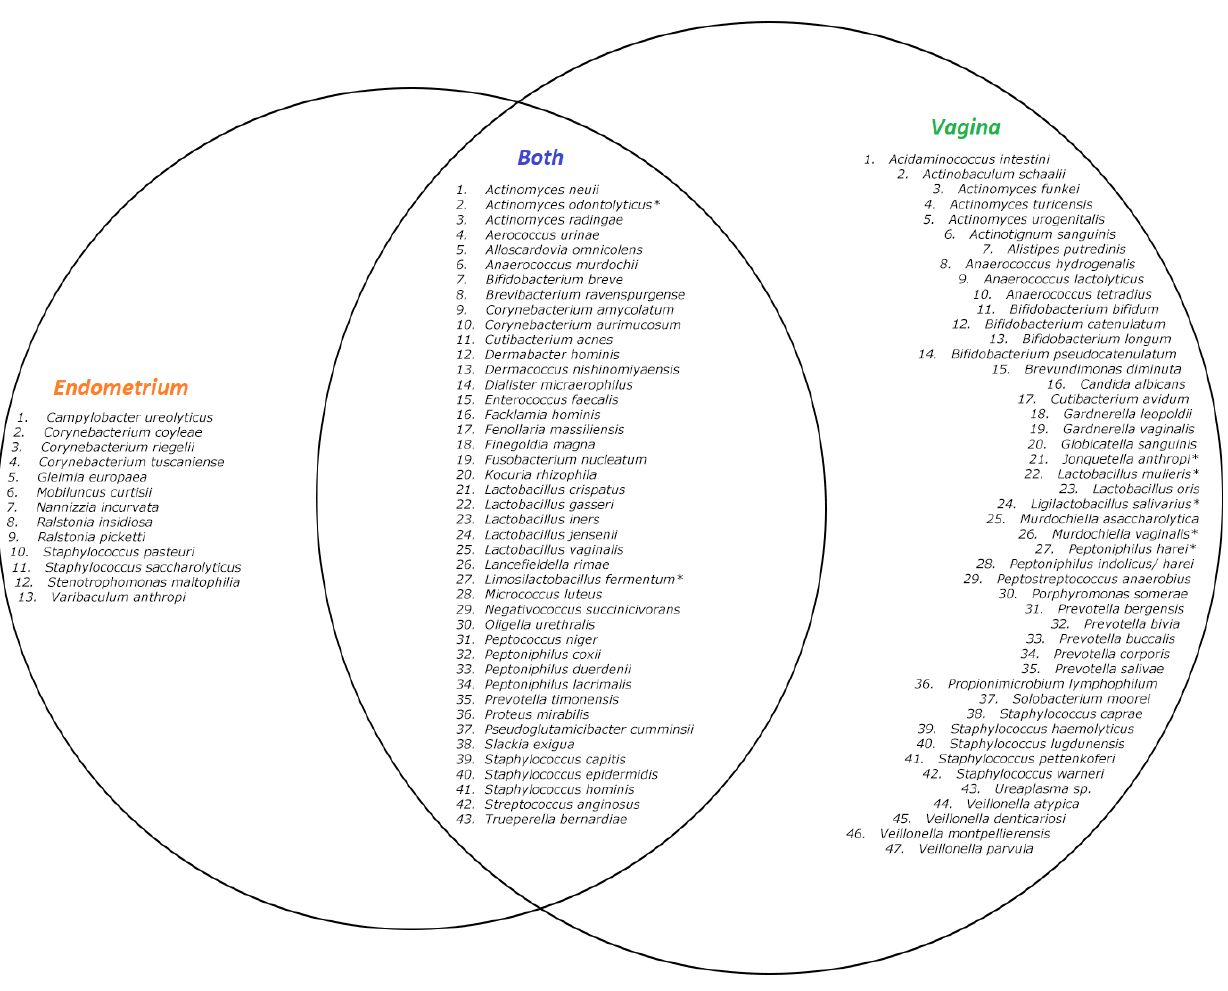
Figure 2. Venn diagram of described species in the 10 samples with culturomics. Left circle: species only found in the endometrium. Right circle: species only found in the vagina. Inner circle: species found in both the vagina and endometrium. * Species identified using 16S rRNA sequencing.